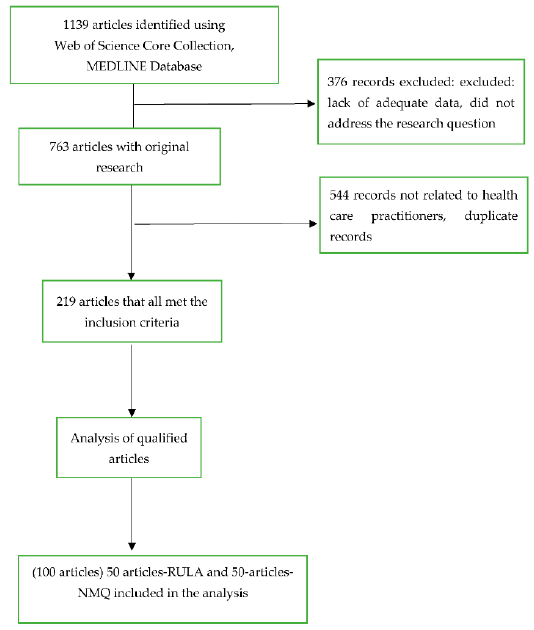
Figure 1. Flowchart illustrating the procedure of allocation of articles.